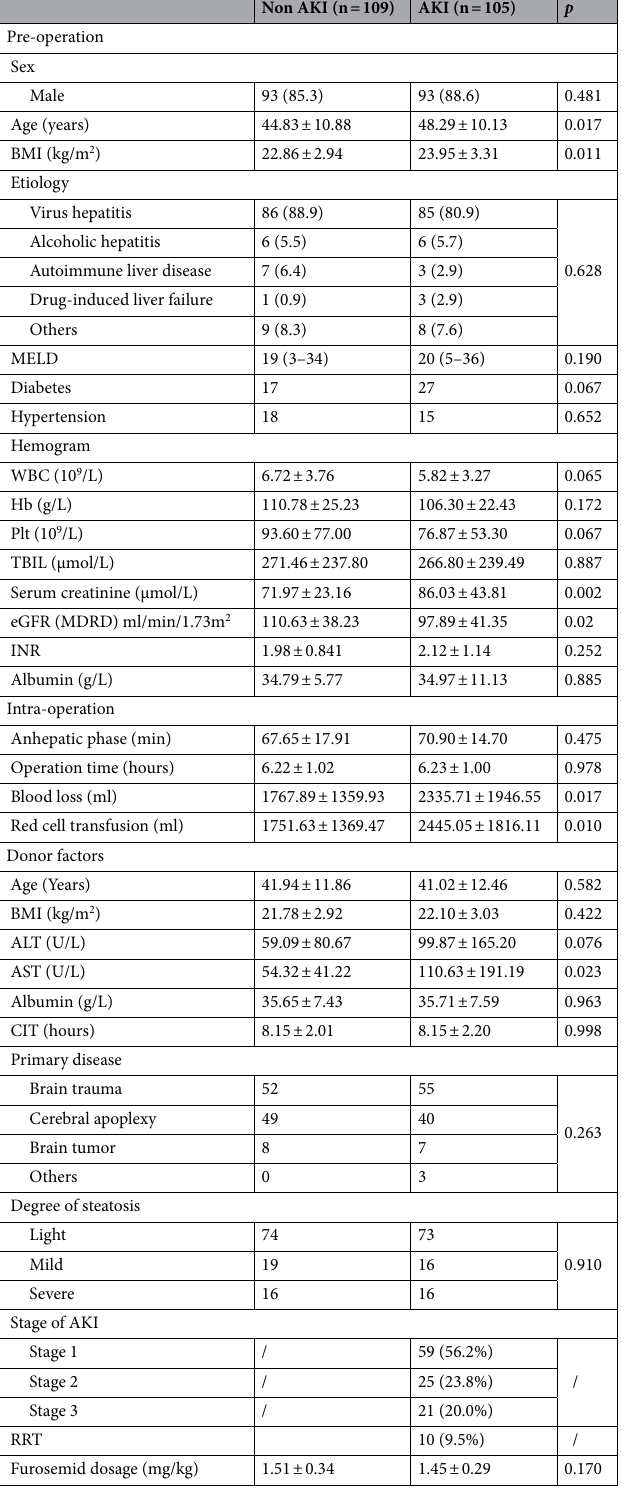
Table 1. Basic characteristics of the perioperative period of the recipient. BMI body mass index, MELD model for end-stage liver disease score; AKI acute kidney injury, eGFR estimated glomerular filtration rate, WBC white blood cell, Hb hemoglobin, Plt pletelet, TBIL total bilirubin, INR international normalized ratio, ALT alanine aminotrans, AST aspartate aminotransferase, CIT cold ischemia time, AKI acute kidney injury, RRT renal replacement